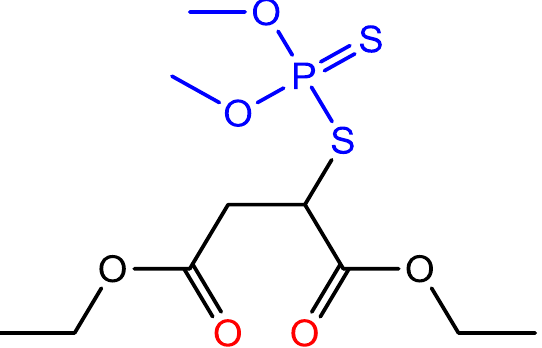
Figure 1. Malathion chemical